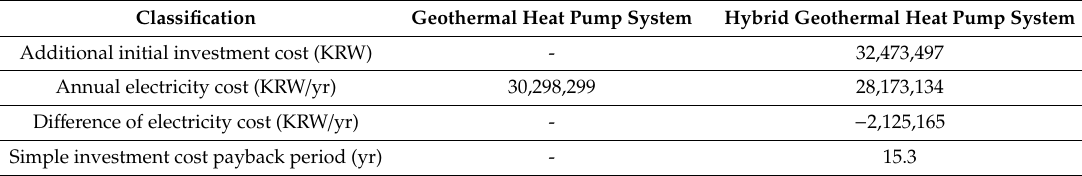
Table 10. Results of economic analysis of hybrid geothermal heat pump